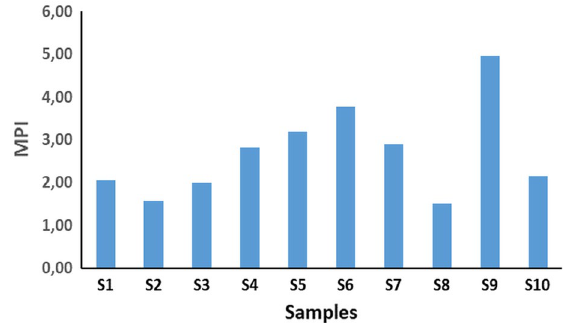
Figure 1. MPI values of analyzed wood pellet ashes.